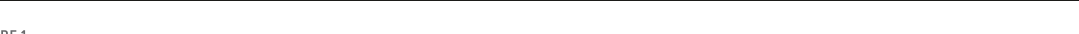
FIGURE1 (D) Upper and middle panels show adjacent FIB-SEM images of an adjacent bouton (AdjAx, green) projecting a no-CT spinule into an SBB (purple) that has a synapse with a postsynaptic spine (uncolored PSD, top left of SBB). Bottom panel shows the 3D reconstruction of this AdjAx with its large no-CT spinule enveloped by the SBB, and the SBB’s PSD (red) with the postsynaptic spine (not shown). Note the second small CT AdjAx spinule projecting into the very bottom of this SBB. (E) Upper and middle panels show two FIB-SEM images of an adjacent spine (no PSD with this SBB; AdjS; orange) projecting (top panel) a large no-CT spinule into an SBB that becomes fully enveloped (lower panel). Bottom panel shows the 3D reconstruction of this AdjS, SBB, and SBB’s PSD (red). Note the spinule’s small ( ∼ 30 nm) invagination site (top and bottom panels) that expands into a large, enveloped structure that extends through the majority of this SBB’s length (middle and bottom panels). (F) Upper and middle panels show two successive FIB-SEM images of an adjacent dendrite (AdjD, yellow) projecting a no-CT spinule into an SBB (purple), with the spinule fully enveloped by the SBB (middle panel).Bottom panels show the 3D reconstruction of the surface of this dendrite and its non-synaptic spinule encapsulated by this SBB with a synapse (red) onto a dendritic spine from a separate dendrite (not shown). (G) 3D reconstruction of a segment of a dendrite and its spines, a majority of which project spinules into SBBs. All spinules from an individual spine are pseudocolored with the same color. Note that individual spines may project both CT and no-CT spinules (e.g., red and cyan spinules). (G 1 ,G 2 ) Single FIBSEM sections showing large no-CT spinules within SBBs (purple) emanating from distinct spines (arrows), and the 3D reconstruction of these SBBs (at right) displaying the enveloped spinule and PSDs (red). (G 3 ) FIB-SEM image and 3D reconstruction showing a small CT spinule (cyan) enveloped by an SBB (purple), displaying an annulus-shaped perforated PSD (red). (G 4 ) FIB-SEM image and 3D reconstruction showing an SBB enveloping a spine head spinule (peach) and displaying two macular PSDs (red). (G 5 ) 3D reconstruction (arrow origin) and two successive FIB-SEM images showing an inhibitory presynaptic bouton (blue) with a synapse (symmetric PSD at left of bouton) onto a large pyramidal cell apical dendrite, and two enveloped spinules (pink and yellow) from nearby synaptic spines. (H) 3D reconstruction of four excitatory axons (orange, purple, magenta, and green), and one inhibitory axon (blue), projecting AdjAx spinules into each other, with visible PSDs (red). Arrows point to FIB-SEM images of the same SBB and AdjAx spinule relationships. (H 1 ) Two successive FIB-SEM images showing an adjacent axon projecting a large no-CT spinule (orange) containing presynaptic vesicles into an SBB (purple). (H 2 ) Two successive FIB-SEM images showing an adjacent presynaptic bouton (magenta) projecting a large no-CT spinule into an SBB (purple). Note that the individual synapses that both boutons have with postsynaptic spines are visible as dark PSDs at top and bottom of image at left. (H 3 ) FIB-SEM image (left) and 3D reconstruction (right) showing the reciprocal relationship to panel (H 2 ), with SBB from magenta axon enveloping an AdjAx spinule from the purple axon’s presynaptic bouton and PSDs shown in red. (H 4 ) Two successive FIB-SEM images showing an AdjAx (magenta) with a spinule into an inhibitory presynaptic bouton (blue). (H 5 ) Two successive FIB-SEM images showing another AdjAx (green) with a spinule into this same inhibitory presynaptic bouton (blue) with a synapse (symmetric PSD) onto a dendritic shaft (top FIB-SEM image and red PSD opposite green spinule in 3D reconstruction). Scale bars (A) 1 µ m, (C–H) 0.5 µ m; Scale cubes (C–H) 0.5 µ m per side.